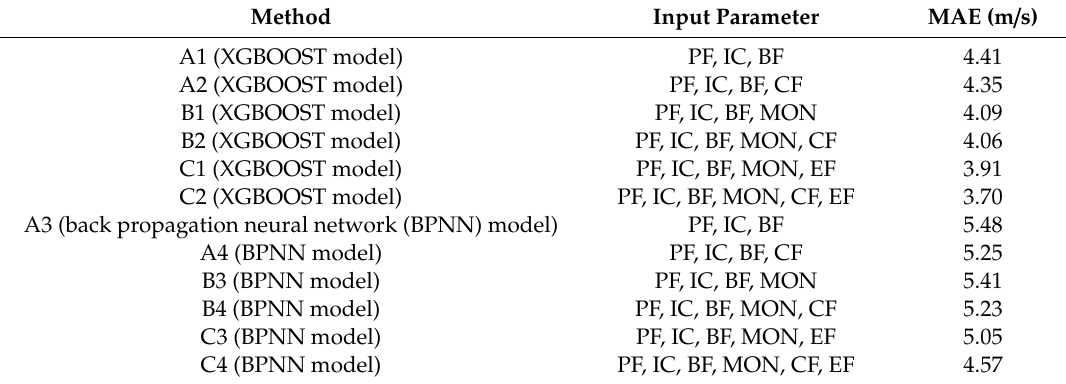
Table 8. Mean absolute error of tropical cyclone intensity for several forecast methods with a 24 h lead